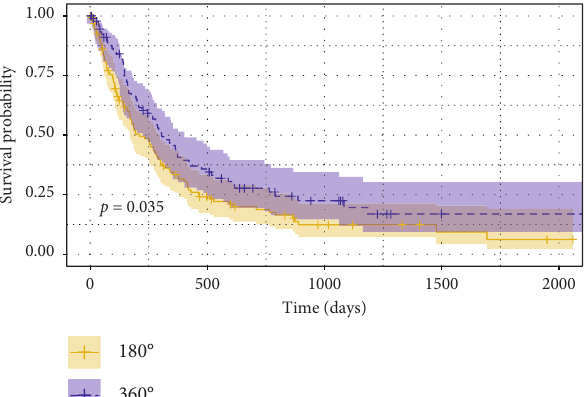
Figure 1: Kaplan–Meier curve comparing the cumulative probabilities survival following 180 ° and 360 ° of SLT (Lumenis, Coherent, Inc, Palo Alto, CA, USA). The shaded areas around each plot represent the 95% confidence bands. Success was defined as ≥ 20% IOP reduction from baseline with an IOP between 5–18 mmHg and ≤ 1 glaucoma medication added postoperatively. A failure was recorded if a patient either failed to meet success criteria at two consecutive follow-up visits or required an additional IOP-lowering procedure. The log-rank test was used to detect statistical differences between the curves. IOP � intraocular pressure; SLT � Selective Laser Trabeculoplasty; mmHg � millimeters of